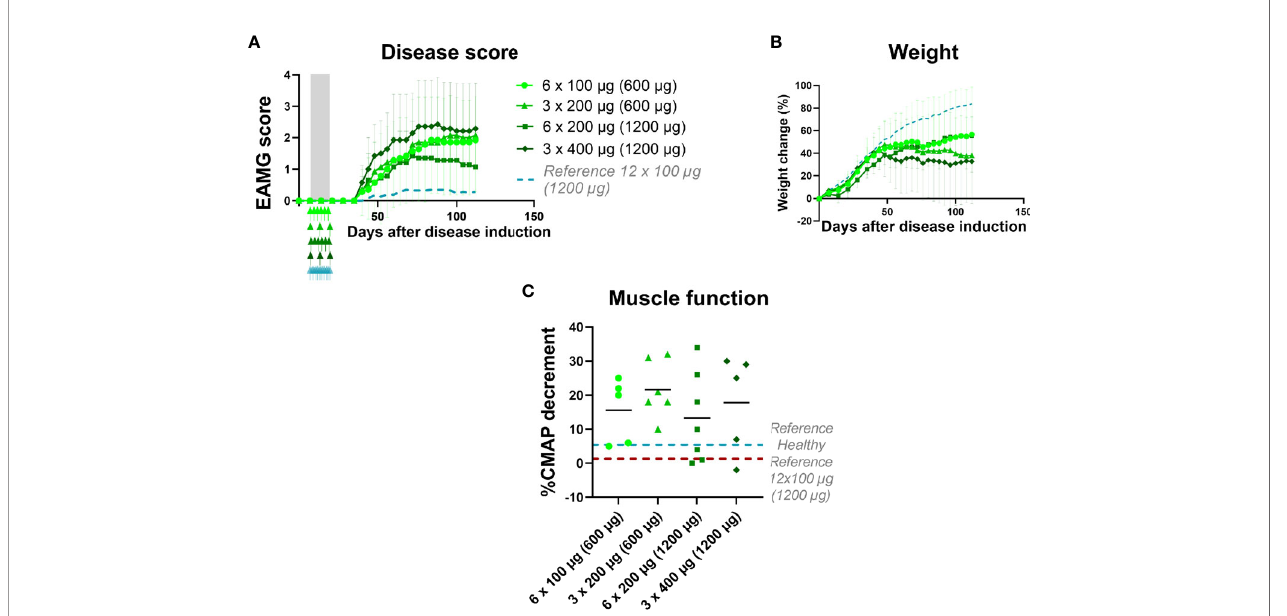
FIGURE 4 | EAMG treatment ef fi cacy of a 1-ECD mt depends on dosing frequency. EAMG rats received a 1-ECD mt at different doses and frequencies starting from day 7 of the experiment and over 12 days: 100 m g every other day (N=7, circles; 600 m g in total), 200 m g every other day (N=7, triangles; 1200 m g in total), 200 m g every fourth day (N=7, squares; 600 m g in total), or 400 m g every fourth day (N=7, rhombus; 1200 m g in total). (A) Average EAMG scores (± SD); the grey bar indicates the treatment period and arrows the timing of each administration. A dotted line represents rats treated with 12 x 100 m g daily administrations for reference. (B) Average percentage of body weight change (± SD). (C) CMAP decrement: each symbol corresponds to one rat and the bar shows the mean